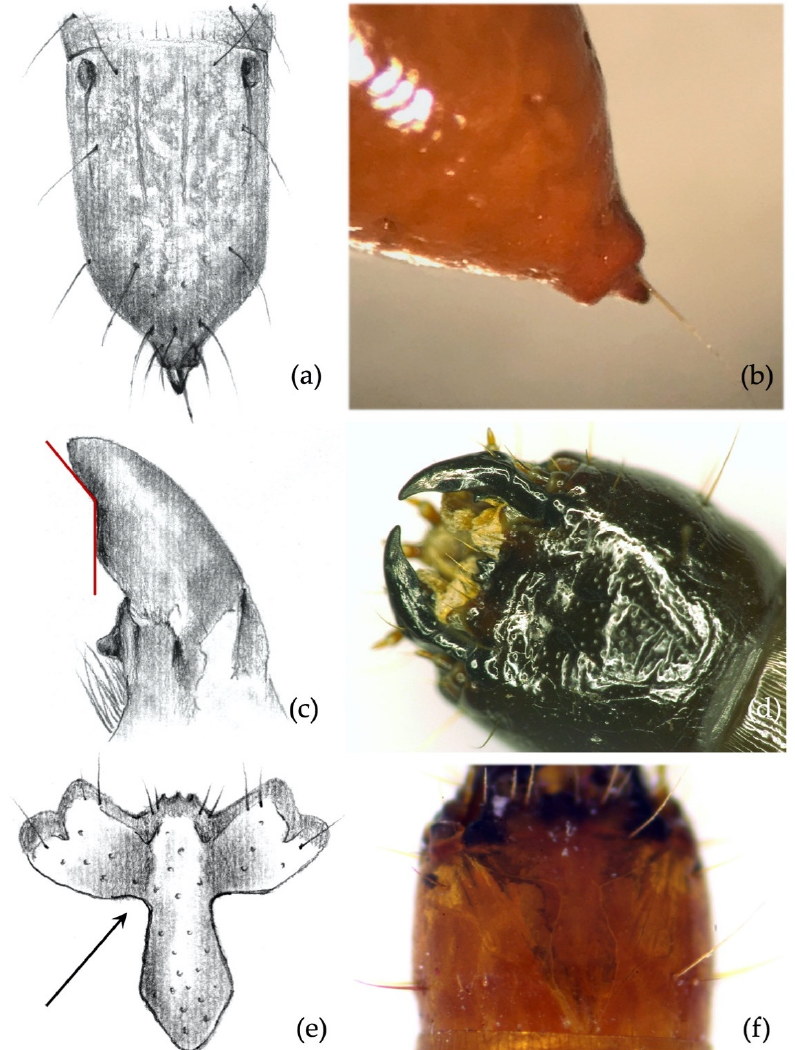
Figure 5. Agriotes sordidus (Illiger 1807). Discriminating characters: ( a , b ) shape of the caudal part of the 9th abdominal segment with large bulge and terminal spike; ( c ) details of the right mandible with prominent subapical tooth forming an angle far greater than 90°; ( d ) view of the mandibles; ( e ) details of the frontoclypeus, forming a right angle; ( f ) view of the head with visible